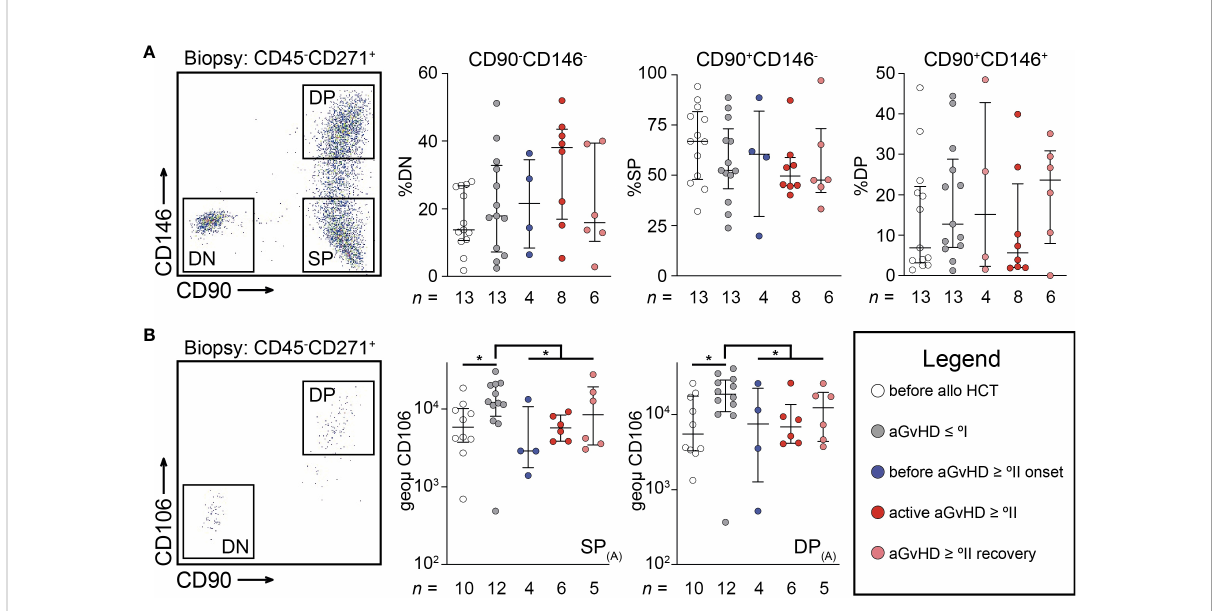
FIGURE 2 Uncultured mesenchymal stromal cells reveal dynamic endotypes after allogeneic stem cell transplantation. (A) Representative scatterplot showing three distinct endotypes of PI − CD235a − CD45 − CD271 + cells (MSC) isolated from a trephine biopsy according to CD90 and CD146 expression. Here, frequency of MSC endotypes according to CD90 and CD146 expression are shown for double negative (DN: CD90 - CD146 - ), single positive (SP: CD90 + CD146 - ), and double positive (DP: CD90 + CD146 + ), respectively. (B) Representative scatterplot showing the exclusive expression of CD106 within CD90 + MSCs from BM aspirates. The intensity of CD106 expression was separately analyzed on SP or DP endotypes as de fi ned in (A) . Graphs show individual values with median and interquartile ranges. The Mann-Whitney U-tests were used for statistical analyses. n, number; * P <